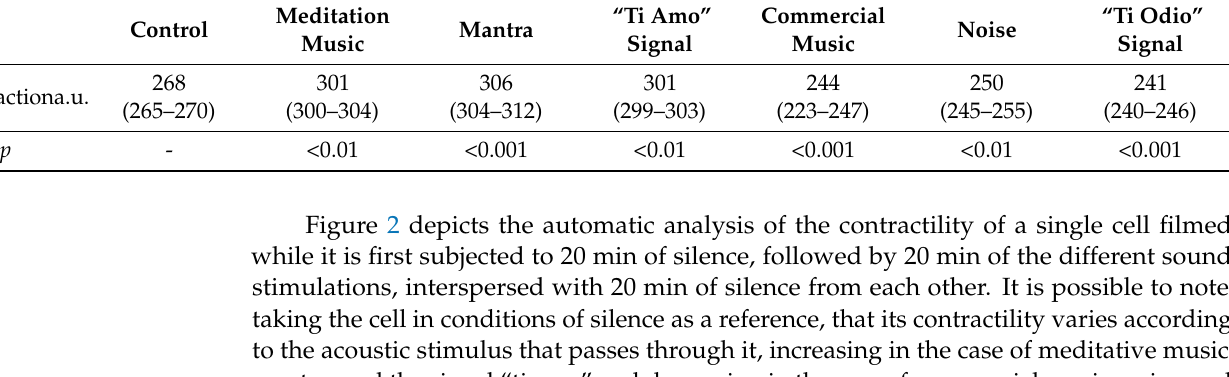
Table 1. Contractility automatic analysis of the same cell under the different acoustic stimulations with statistical analysis. Commercial Meditation Control Signal Contractiona.u.